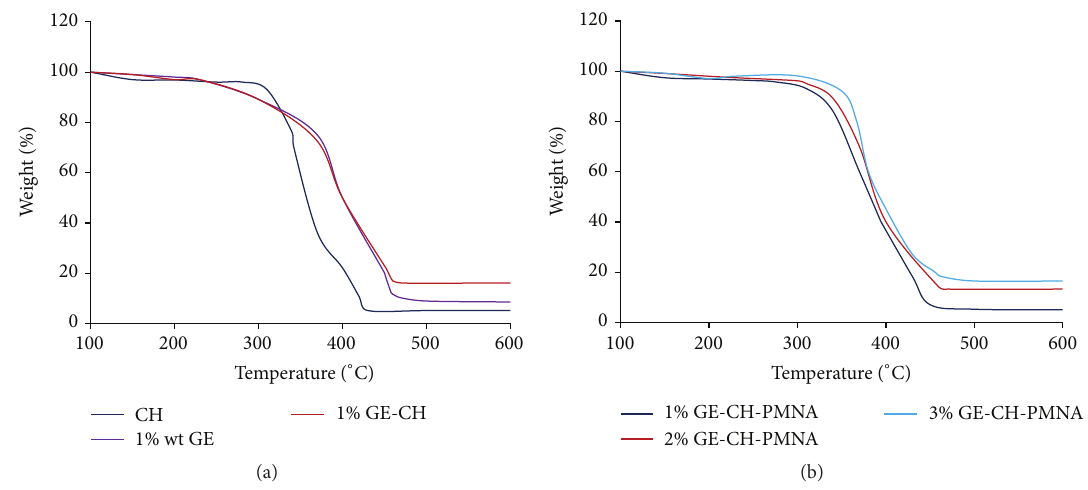
Figure 5: TGA profiles for (a) CH, 1wt% GE, and 1% GE-CH and (b) 1, 2, and 3wt% GE-CH-PMNA.